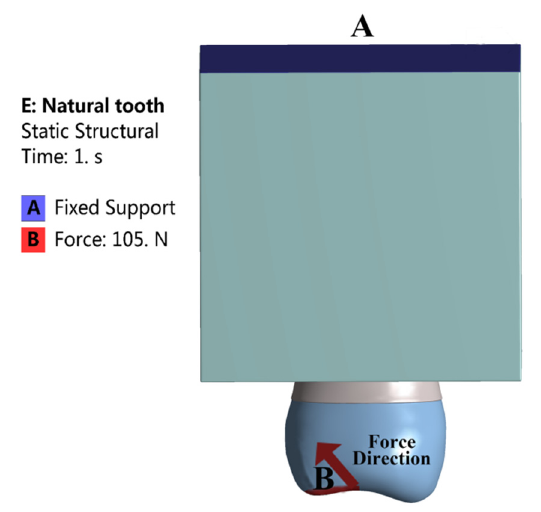
Figure 2. Mesh of Prototypes. ( A ) Mesh of Prototype 1. ( B ) Mesh of Prototype 2. ( C ) Mesh of Prototype 3.